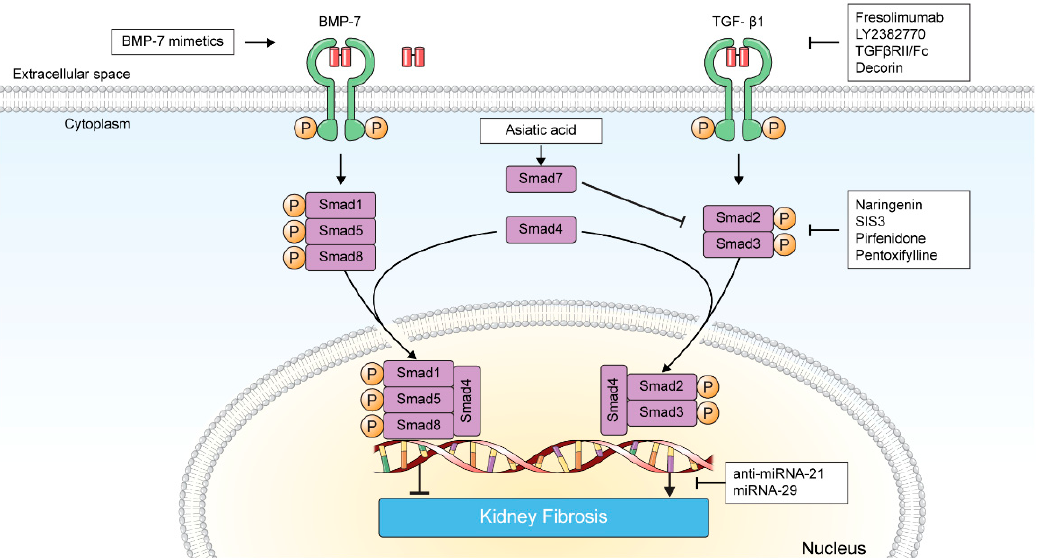
Figure 2. Therapeutic approaches to inhibit TGF- β /Smad-induced kidney fibrosis. Anti-TGF- β antibodies, TGF β RII/Fc, and decorin directly influence TGF- β and TGF- β receptor bindings. BMP- 7 mimetics, asiatic acid, naringenin, SIS3, pirfenidone, and pentoxifylline inhibit TGF- β /Smad signaling. Anti-miRNA-21 oligonucleotides and miRNA-29 modulate the transcription product of TGF- β /Smad signaling pathway.